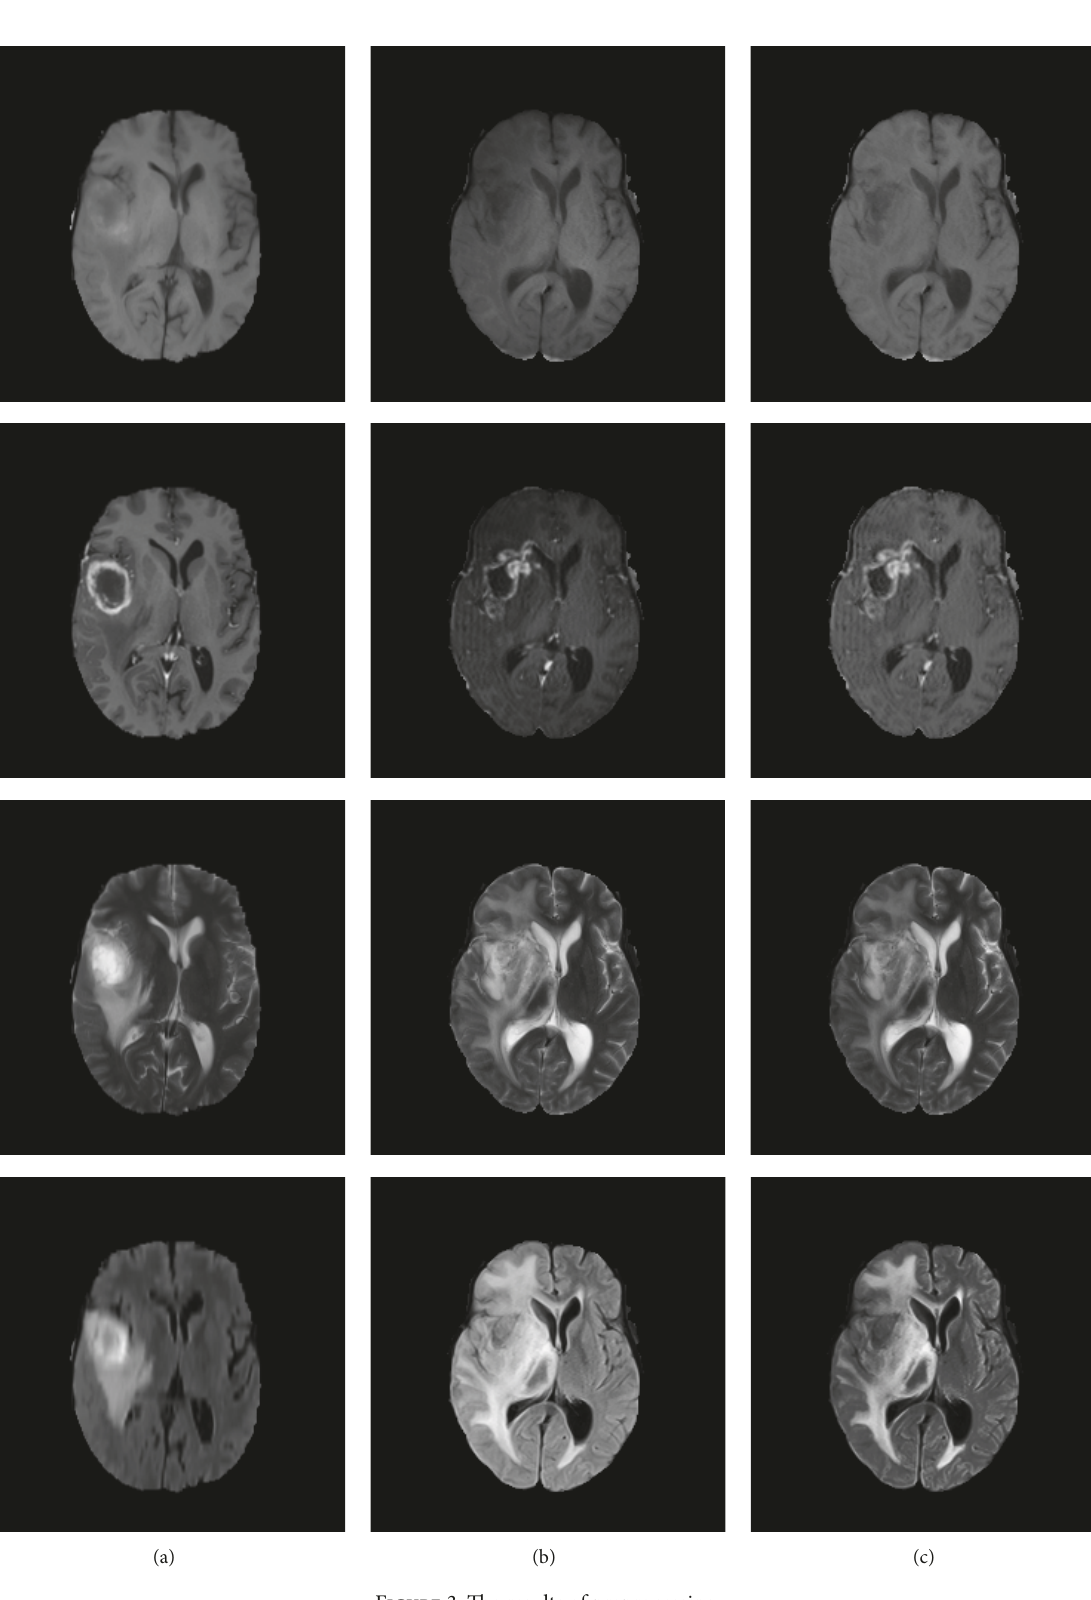
Figure 3: The results of